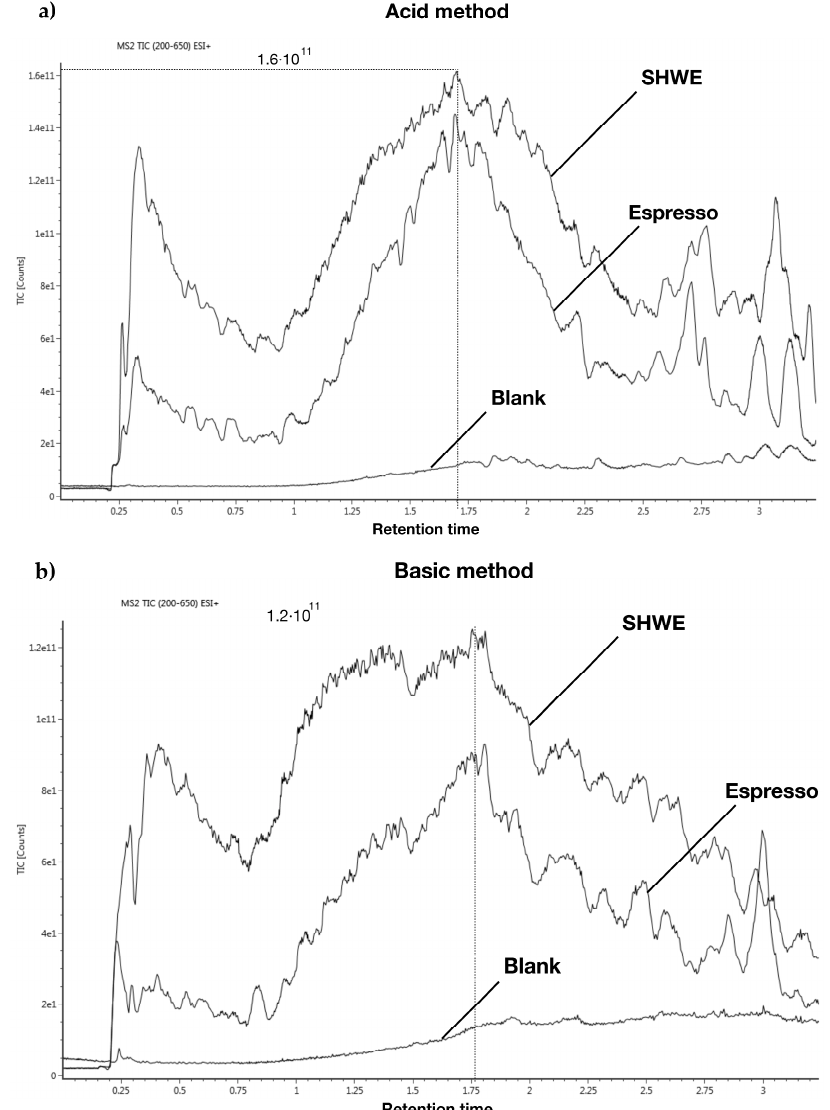
Figure 2. TIC spectra obtained using Waters RADAR TM function of full scan (MS). Panel ( a ) shows TICs obtained for a blank sample as well as sewage sludge extracts applying the Espresso method and the PHWE method at acid chromatographic conditions. Panel ( b ) shows TICs for the same samples types but analyzed at basic chromatographic conditions.